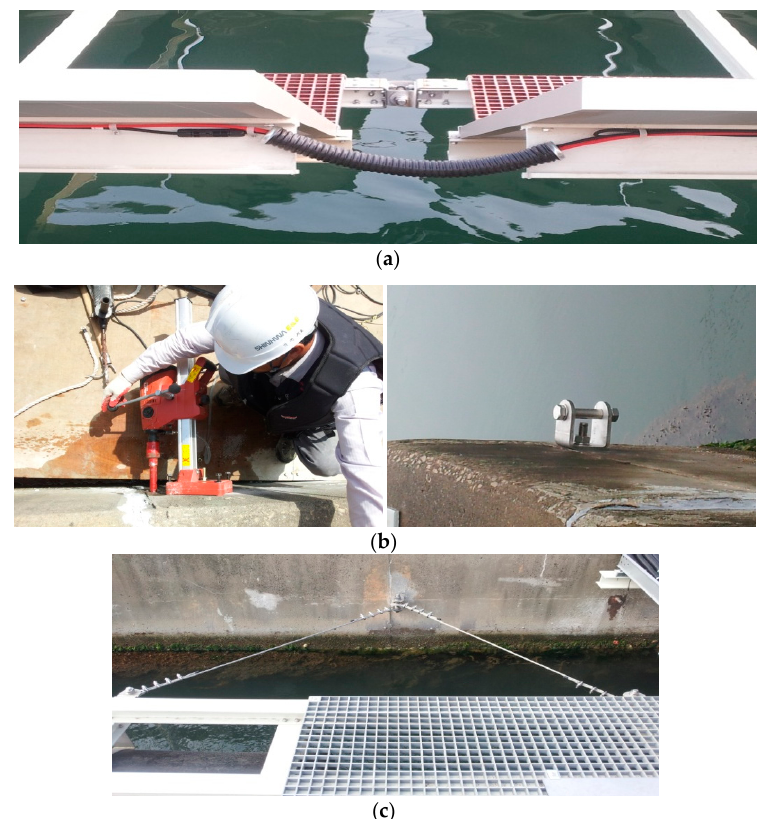
Figure 13. Lifting and launching process; ( a ) Lifting; ( b ) Launching.